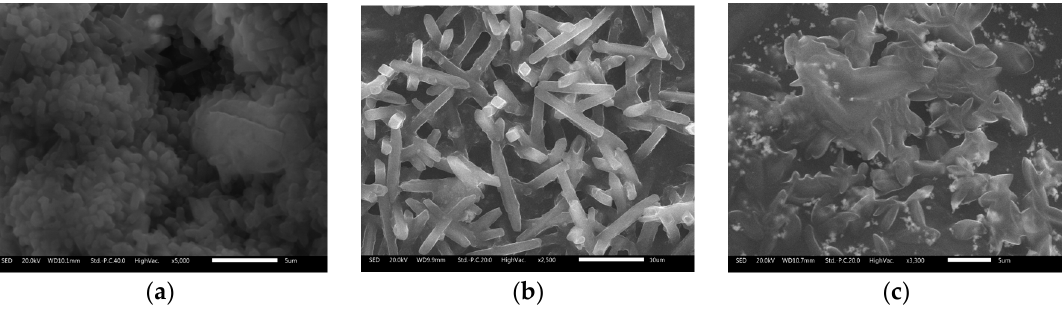
Figure 1. Scanning electron microscopy (SEM) images of the as-milled materials: ( a ) 2LiBH 4 + Al; ( b ) 2LiBH 4 + Al/TiF 3 ; ( c ) 2LiBH 4 + Al/CeO 2 .